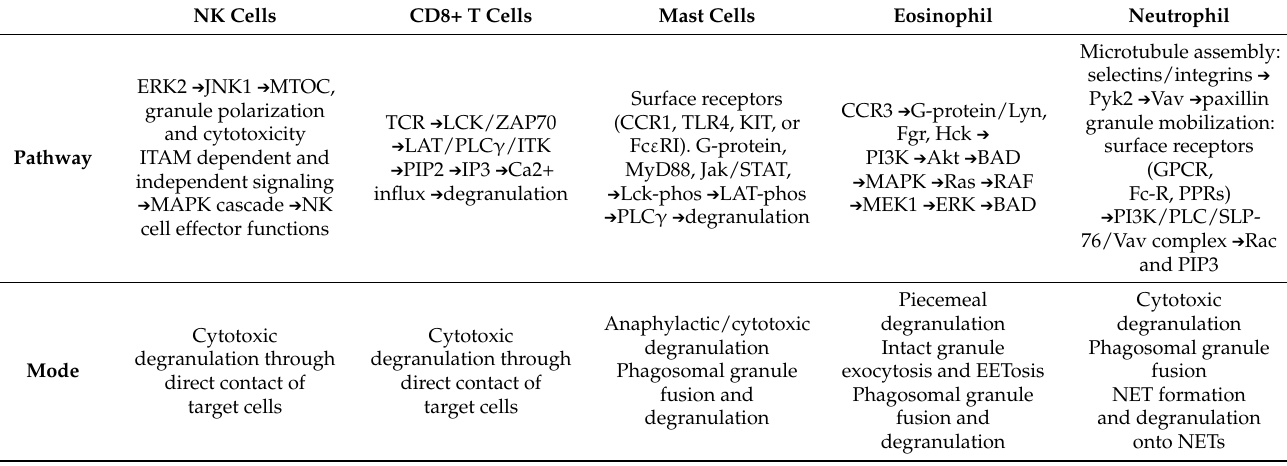
Figure 1. Panel A : Electron micrographs showing the heterogeneity of RNK-16 (NK cell) granules. ( A a) Type I granules. ( A b) A type II granule. ( A c) An intermediate granule with small cores (figure from [7] with permission). Panel B : rat mast cells with dark electron-dense granules (figure from [11] with permission). Panel C : cytoplasmic granules of eosinophils include many membrane-bound, large, dense, spherical, crystalloid-containing granules; less numerous, large, dense, spherical, crystalloid-free granules (figure from [12] with permission). Panel D : neutrophil morphology visualized by electron microscopy. (Top left, top right) The cytosol of a resting cell is filled with vesicles, with primary granules (P) staining intensely dark with diaminobenzidine, while secondary (S) and tertiary (T) granules show more translucent staining. Secretory vesicles (SV) are near the Golgi complex (G). Few mitochondria (M) are observed. (Bottom left, bottom right) (figure from [13] under Creative Commons Attribution License (CC BY)). Table 2. Pathways and modes of degranulation in various immune